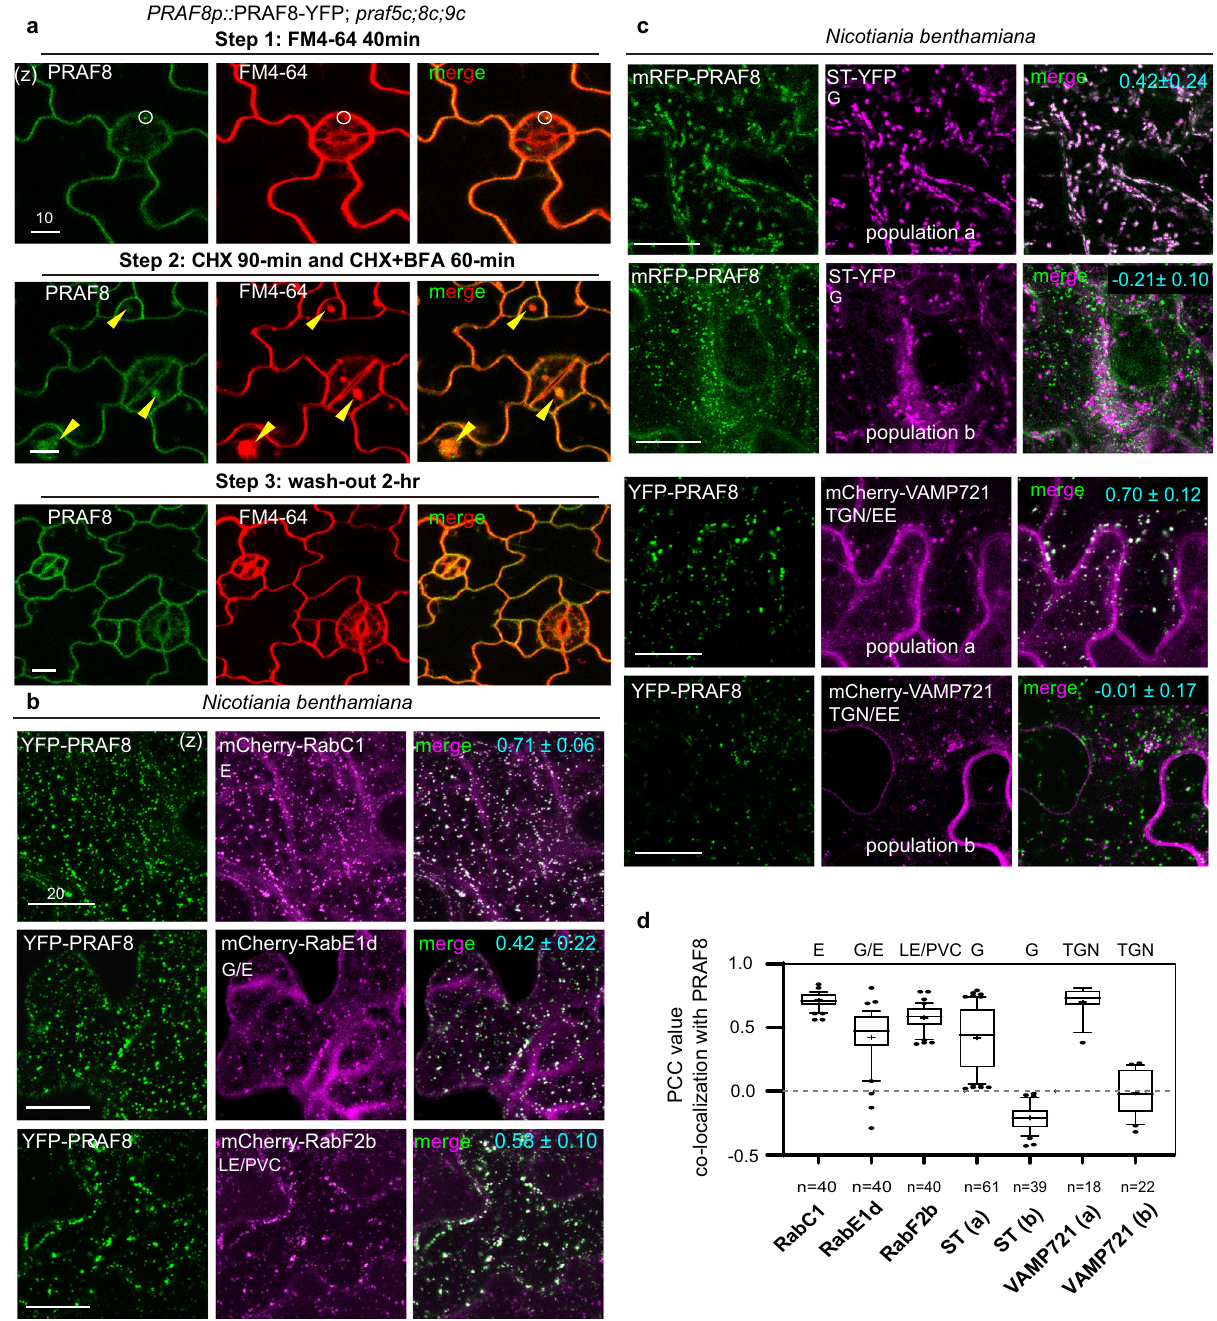
Fig. 4 Intracellular PRAF8 partially associates with the Golgi, TGN/EE, and endosomes. a PRAF8-YFP associates with the endosomes. Top panel: confocal images of PRAF8-YFP (green) in cotyledon epidermal cells stained with the endocytic tracer marker, 8 μ M FM4-64 (red) for 40-min (step 1). White circles: overlapping endosomal signals. Middle, step 2, following FM4-64 staining, seedlings were treated with 50 μ M cycloheximide (CHX, a protein synthesis inhibitor) for 90-min, followed by the addition of the Arf GEF inhibitor, 70 μ M Brefeldin A (BFA), for 60-min. Step 3 (bottom), wash-out with water for 2 h. Yellow arrowheads mark the formation of “ BFA-bodies ” that overlap with PRAF8-YFP-positive aggregates. Data represent the results of three independent experiments. b – c . Co-localization of YFP/mRFP-PRAF8 (green) with mCherry/YFP-tagged endomembrane markers (magenta) in N. benthamiana leaf epidermal cells. Data represent results of three independent experiments. The co-localization rates (PCC, Pearson correlation coef fi cient values) are speci fi ed at the upper-right corner (cyan). G Golgi, E endosome, TGN/EE trans-Golgi network/early endosome, LE/PVC late endosome/ prevacuolar compartment. d Quanti fi cation of protein co-localization based on PCC values in ( b ) and ( c ). For each pair of co-expression, n > 100 regions- of-interest (ROIs, each 228.3 µ m²) were selected to obtain PCC values. ST showed 61/100 ROIs with PCC > 0 (population a), and VAMP721 showed 18/ 100 ROIs with PCC > 0 (population a). Box plots show the fi rst and third quartile (box), median (line), and mean (cross). Data represent the results of three independent experiments. (z), z-stacked confocal image. Scale bars are 10 μ m ( a ) and 20 μ m ( b and c